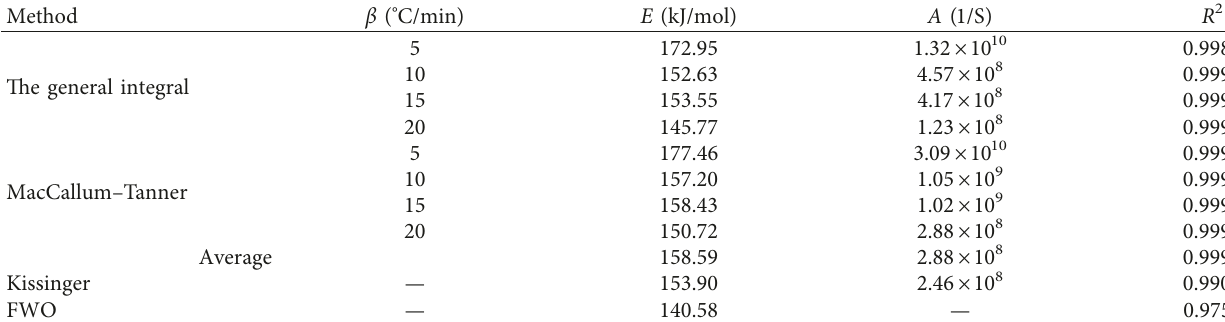
Table 5: Calculation results of coal